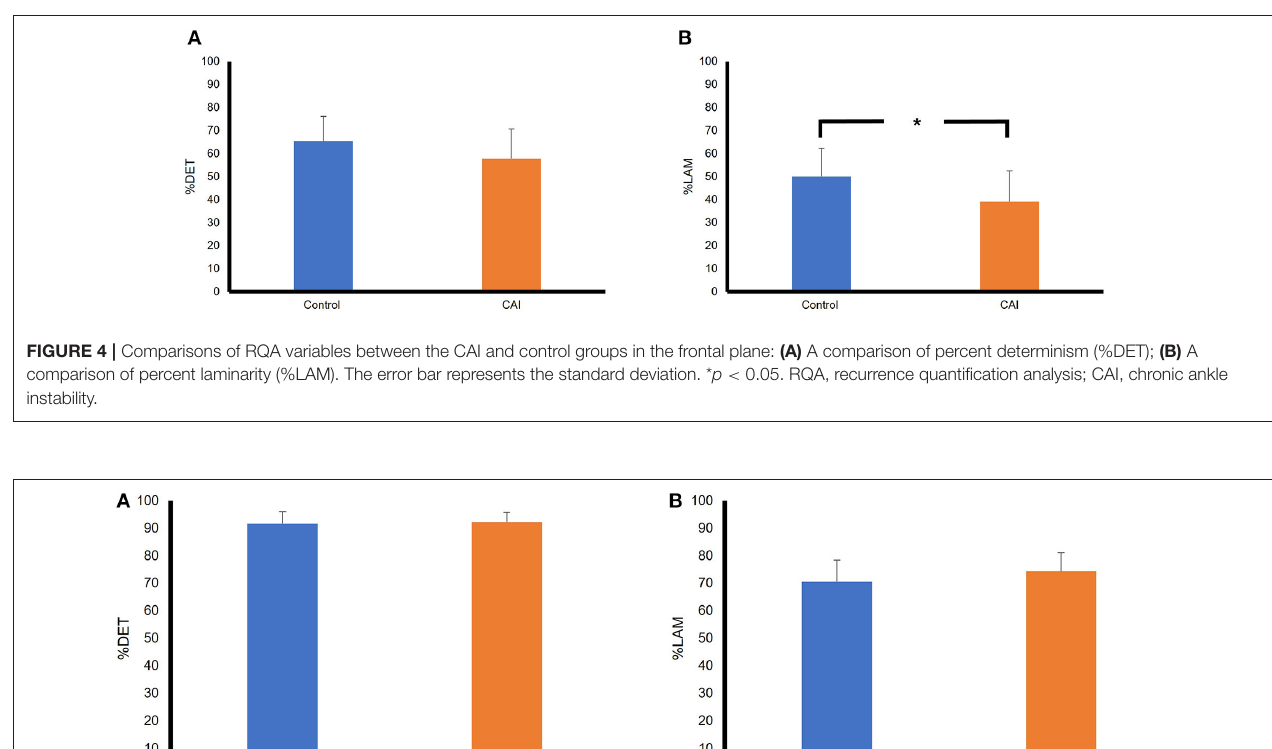
Figure 5 summarizes the results of RQA variables in the sagittal plane. The mean %DET was essentially the same between the groups, t(22) = − 0.53, p = 0.6, Cohen’s d = − 0.03, a small effect. The %LAM was